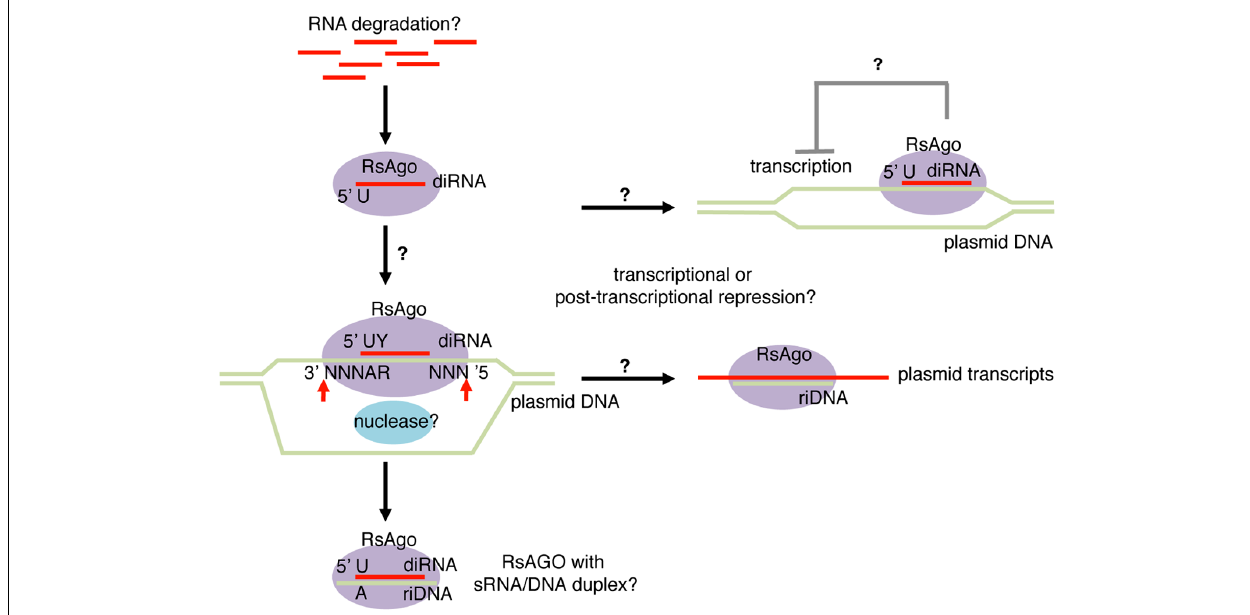
predicted to form duplex structures with diRNAs with 3 nt DNA overhangs at both ends, therefore exhibit adenine (A) and purine (R) enrichment at the fourth and fifth nucleotides counting from the 3 (cid:3) end.The predicted duplex structures led to the hypothesis that diRNAs guide DNA target cleavage at the positions three nucleotides away from the 5 (cid:3) and 3 (cid:3) termini of diRNA. RsAgo represses expression of mRNAs encoded by plasmids by an unknown mechanism transcriptionally and/or